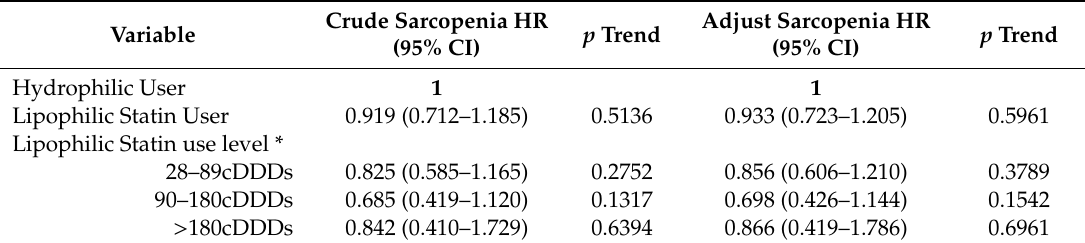
Table 7. Association between lipophilic and hydrophilic of statins and first-time sarcopenia among CKD patients in Taiwan.